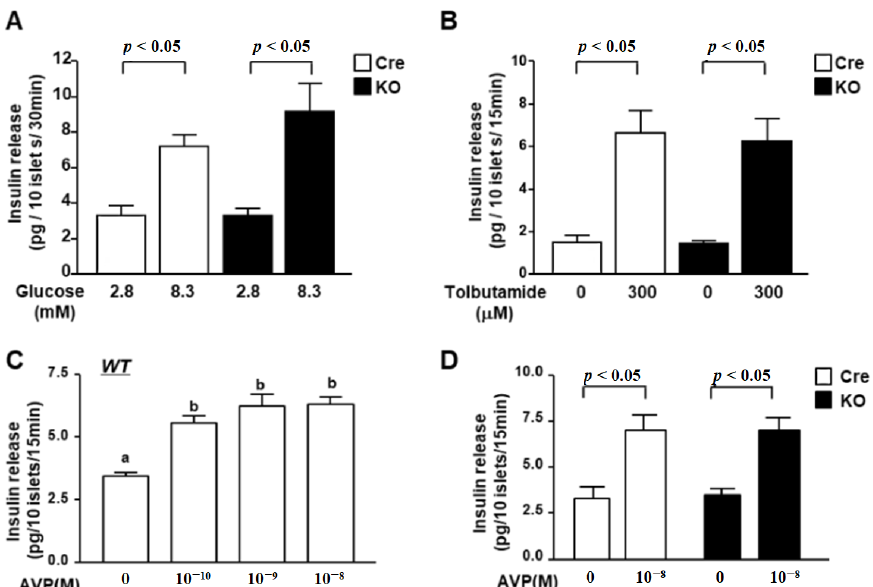
Figure 3. Glucose- and AVP-dependent increases in insulin release from islets of KO mice. ( A ) Insulin release from isolated islets under static incubation with 2.8 mM glucose and 8.3 mM glucose. High glucose (8.3 mM) significantly increased insulin secretion from isolated islets of both Cre mice (white bars) and KO mice (black bars), and the increased level was not significantly different between Cre and KO mice ( n = 6 groups). ( B ) Insulin release from isolated mouse islets by tolbutamide (Tolb: 300 µM) at 2.8 mM glucose. There was no significant difference between Cre mice (white bars) and KO mice (black bars). ( C ) Insulin release from islets of wild C57B6 mice in the presence of 2.8 mM glucose with 10 − 10 , 10 − 9 or 10 − 8 M AVP. Insulin release was stimulated by AVP in a concentration-dependent manner to reach a significant level with 10 − 8 M ( n = 6). a,b Different letters indicate p < 0.05. ( D ) Insulin release from isolated islets under 2.8 mM glucose with 10 − 8 M AVP. AVP significantly increased insulin secretion from isolated islets of both Cre (white bars) and KO mice (black bars). Data are presented as mean ± SEM. Cre vs. KO, 2.8 G vs. 8.3 G, Vehicle vs. AVP, determined by one-way ANOVA followed by the Bonferroni